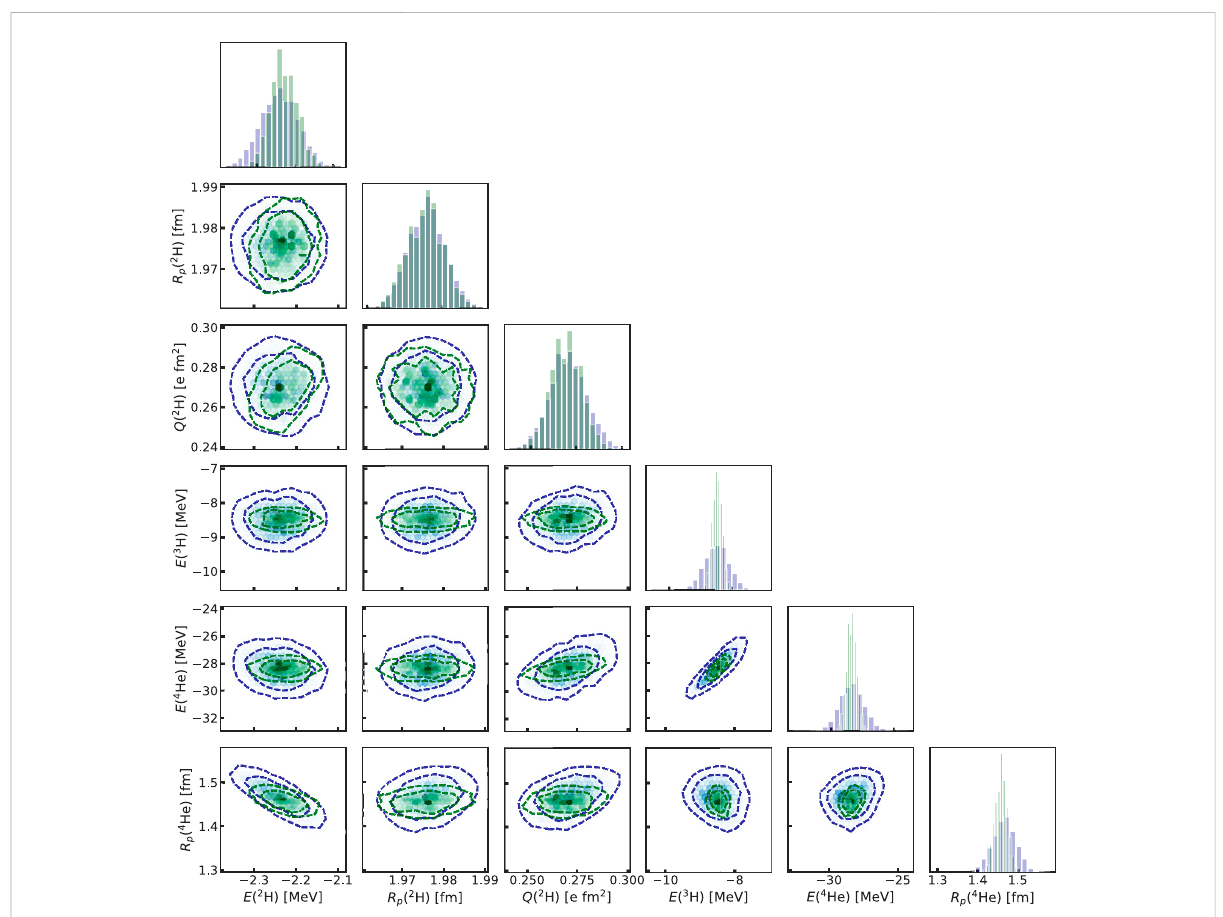
FIGURE 4 The posterior predictive distribution from sampling over two different posterior distributions. PPD A =2 (blue) is calibrated by the deuteron observableswhile PPD A =2,3,4 (green)iscalibratedbythedeuteron, 3 Hand 4 Heobservables.Themarginaldistributionsoftheobservablesareshownin the diagonal